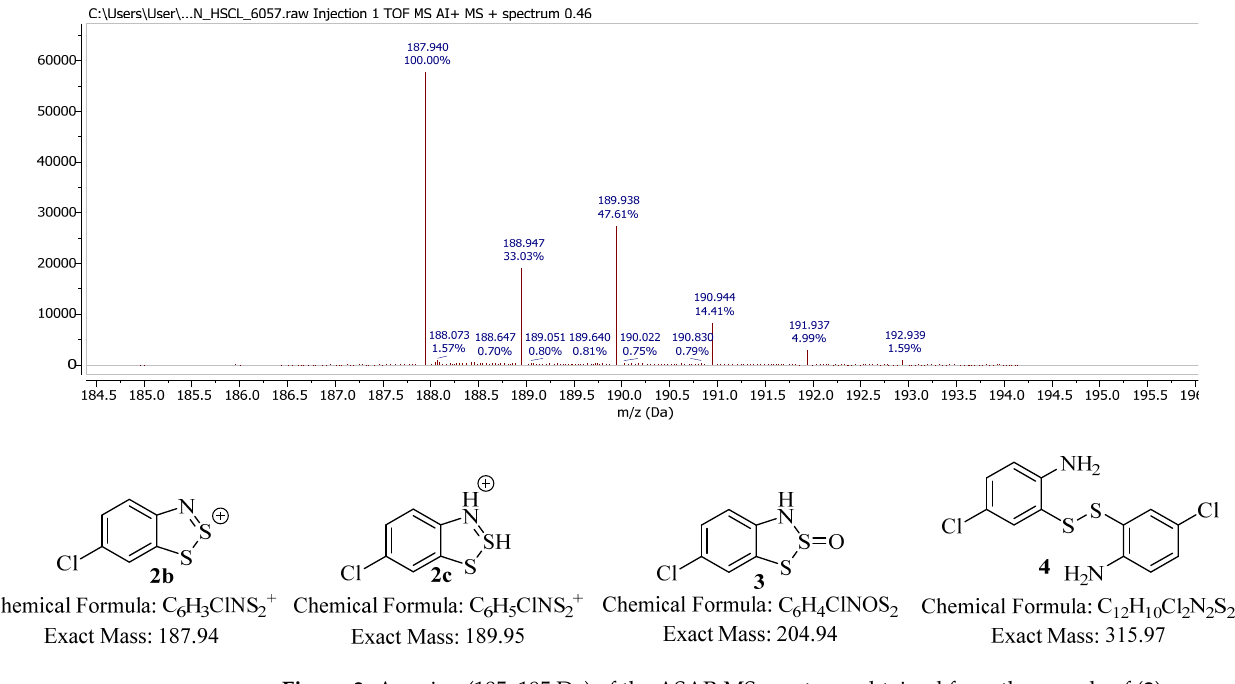
Figure 3. A region (185–195 Da) of the ASAP-MS spectrum obtained from the sample of ( 2 ) generated in this study according to the experimental. Y-axis is (total) ion count. Below are structures with their exact isotopic mass (the structure detected in this spectrum is likely 2b ).